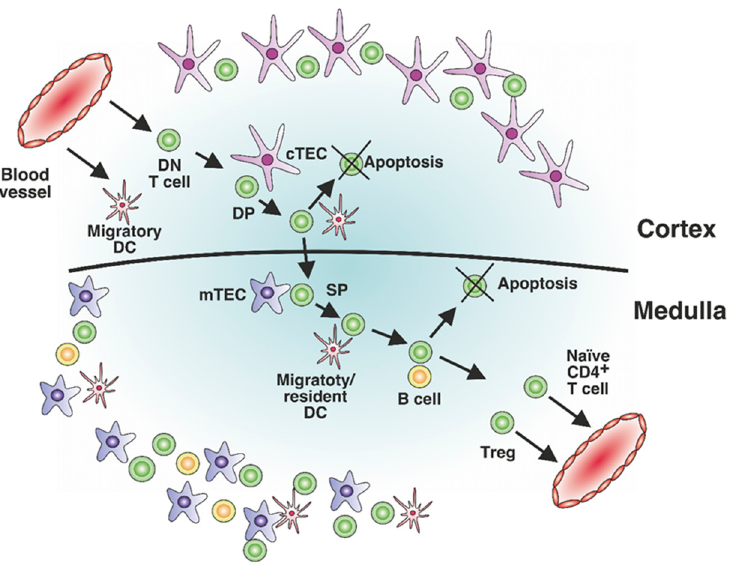
Figure 1. Stages of T cell selection during the establishment of central tolerance. T cell precursor double-negative (DN) T cells enter the cortex of the thymus through a blood vessel to undergo positive selection. Due to the interaction between antigen-presenting cells (APCs) present on cortical thymic epithelial cells (cTECs) and migratory dendritic cells (DCs), double-positive (DP) T cells are differentiated into CD4 + or CD8 + single-positive (SP) T cells and migrate to the medulla of the thymus to undergo negative selection. As they interact with APCs (medulla thymic epithelial cells (mTECs), migratory or resident DCs, and B cells), CD4 + T cells become CD4 + naïve T cells or T regulatory cells (Tregs) and leave the thymus. Negative selection is schematically shown only for SP CD4 + T cells. Extensive genotypic medical statistics indicate that certain MHC-II alleles are asso- ciated, either positively or negatively, with definite autoimmune diseases (ADs).